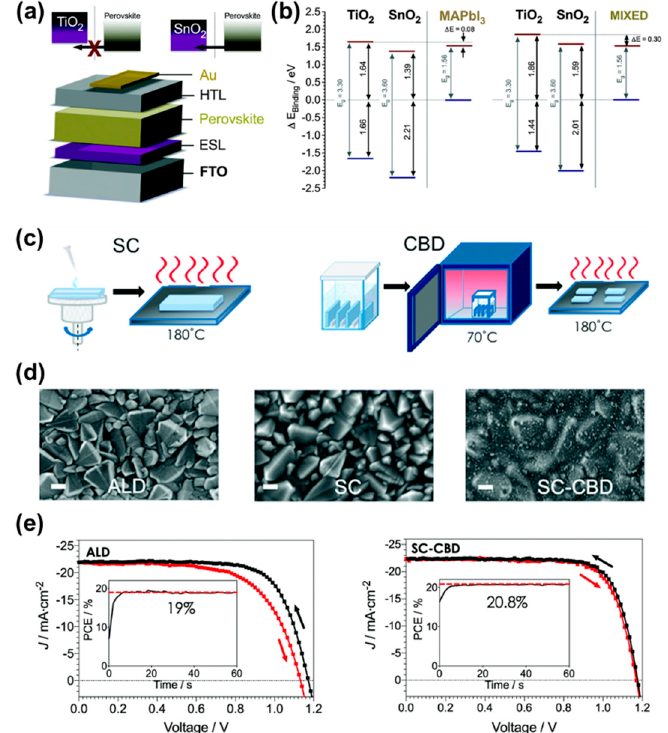
Figure 4. ( a ) Energy band diagram of the perovskite films and the ETL in the planar device with schematic energy band and electron flow in the device. ( b ) Energy band of TiO 2 and SnO 2 with MAPbI 3 and (FAPbI 3 ) 0.85 (MAPbBr 3 ) 0.15 . Reprint with permission [56]; 2015, Royal Society of Chemistry. ( c ) Schematic illustration of preparation of SnO 2 by spin coating and chemical bath deposition. ( d ) Top view images of SnO 2 prepared by ALD, SC and SC-CBD methods. ( e ) J-V and MPP efficiency of the device employed SnO 2 and transient absorption measurement of SnO 2 and TiO 2 based p-PSC. Reprint with permission [57]; 2015, Royal Society of Chemistry.